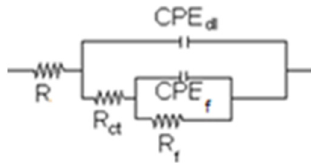
Figure 6. Bode diagrams for T91 steel in 60 wt% NaNO 3 -40%KNO 3 at ( a ) 300, ( b ) 400 and ( c ) 500 °C.